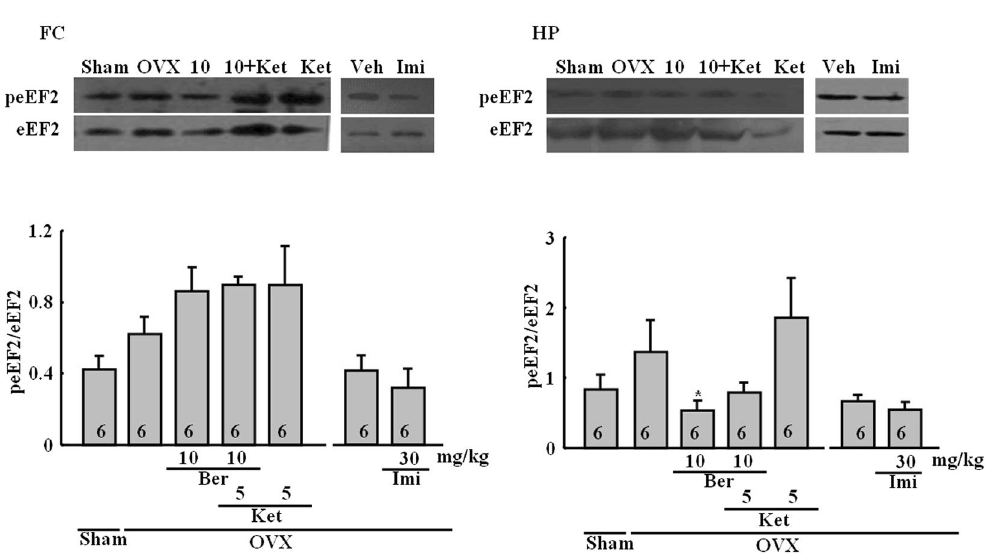
Figure 6. Representative western blots for peEF2 and eEF2. The frontal cortex (FC; left) and the hippocampus (HP; right). Figures represent the peEF 2 /eEF 2 ratios in the FC and HP. Group conditions are indicated by abbreviations and doses by numbers: Sham (sham treatment), OVX (ovariectomy), Ber (berberine, 5 or 10 mg/kg), Ket (ketanserin, 5 mg/kg) and Imi (imipramine, 30 mg/kg). Symbols represent significant post hoc comparisons: Tukey’s HSD, * P < 0.05 vs. OVX